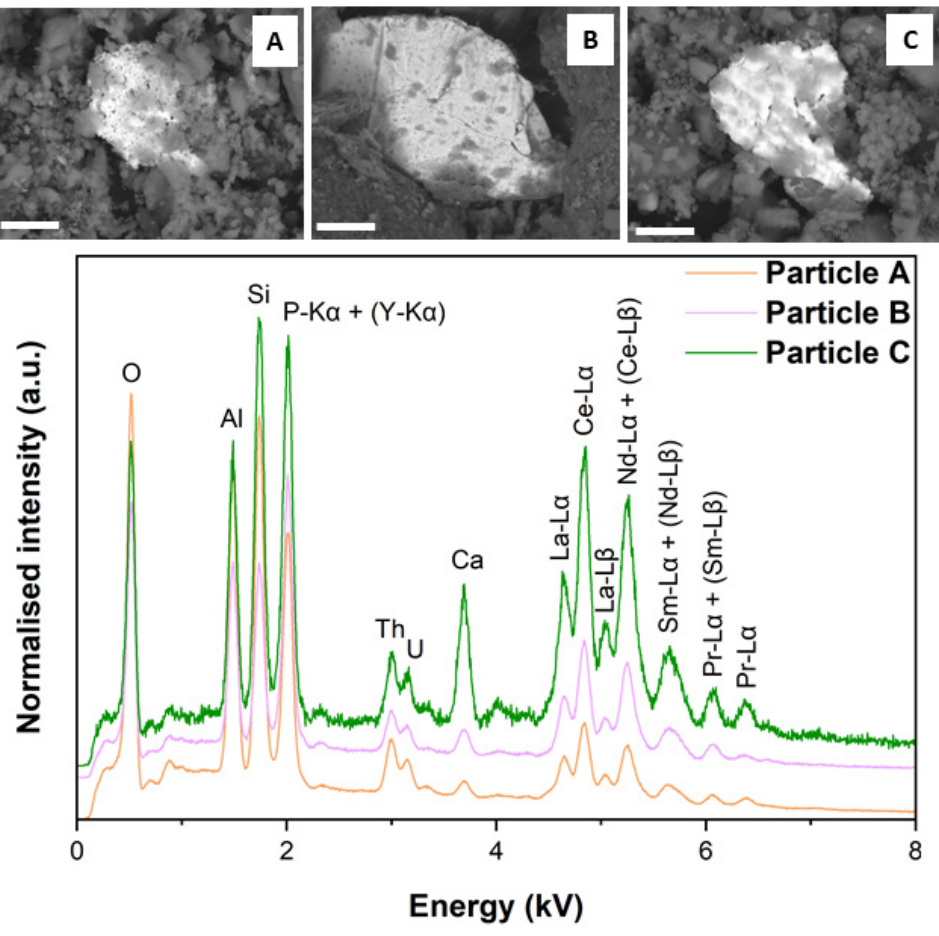
Figure 2. (Top) backscattered electron images of three monazite particles ( A and B in Okaba coal ash; C in Omelewu coal ash). (Bottom) associated EDS spectra with emission peaks identified (scale bars = 10 μ m).